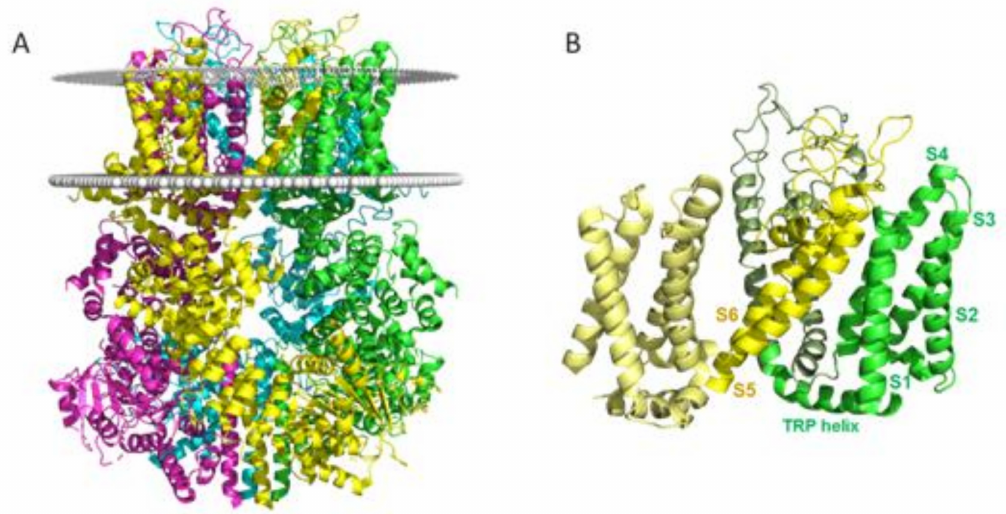
Figure 2. ( A ) Cartoon representation of the full TRPM8 tetramer (based on the structure of pdb code 6O77) [121]. Each subunit is colored differently. ( B ) TM region of two subunits of TRPM8 showing the swapped-domain arrangement. Software for creating images